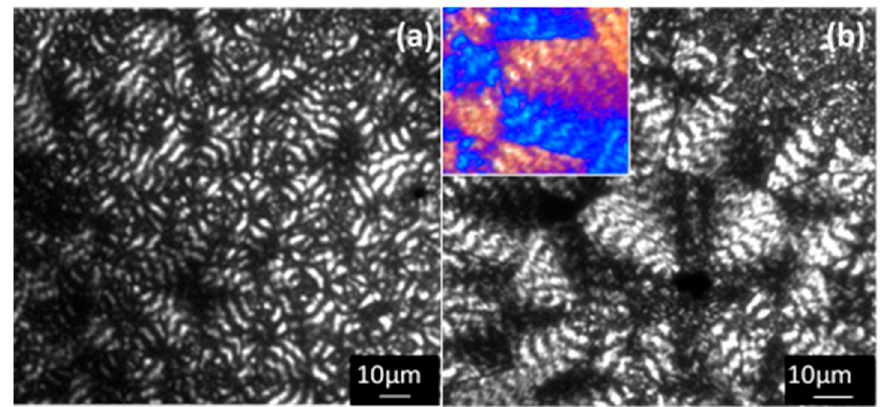
Figure 10. Optical micrographs showing P4HB spherulites crystallized at 36 ◦ C ( a ) and 47 ◦ C ( b ). The inset of ( b ) corresponds to a micrograph taken with a red tint plate.to determine the spherulite